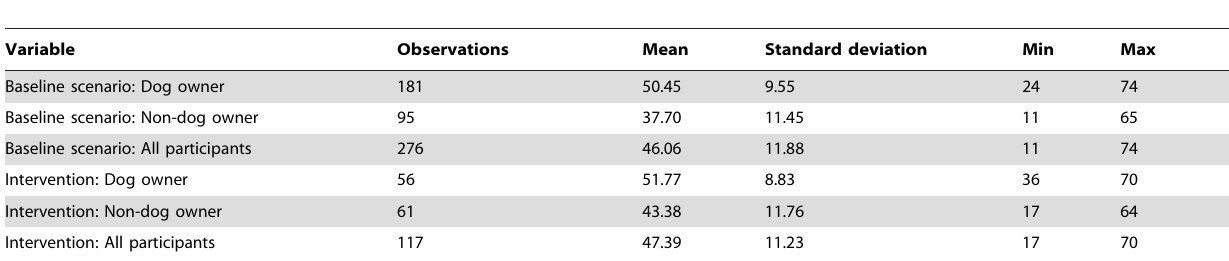
Table 10. Summary table for the dog acceptance scores of dog owners and non-dog owners for the baseline scenario and the intervention.